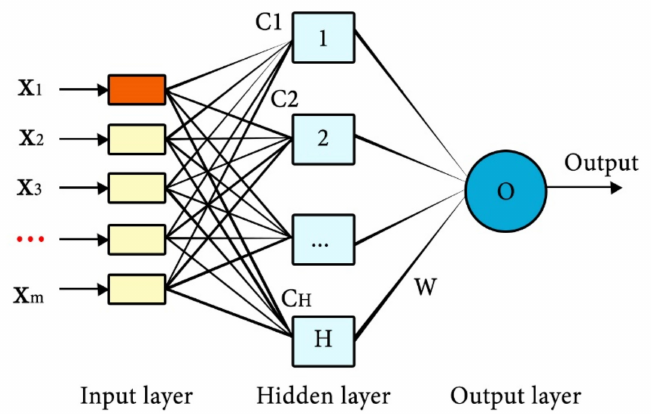
Figure 5. A typical architecture of an RBF neural